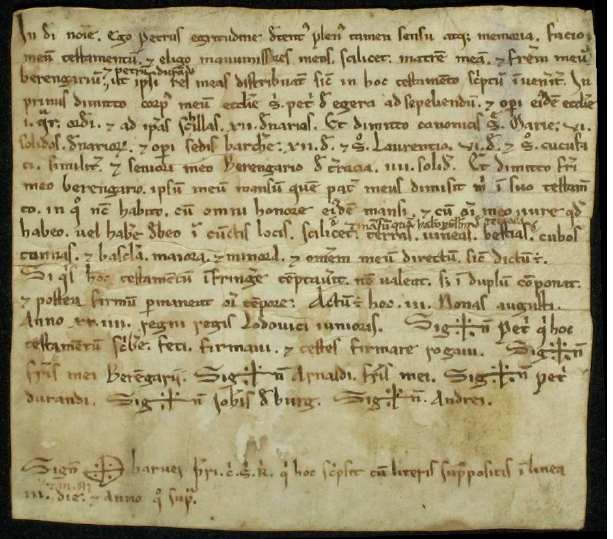
Figure 9. Parchment of the Santa Maria de Terrassa canonry signed by Harvey, ACVOC-AHT. Col- lection Sant Pere de Terrassa. Parchment I-137. 3 August 1160. © Arxiu Històric Comarcal de Ter- rassa.